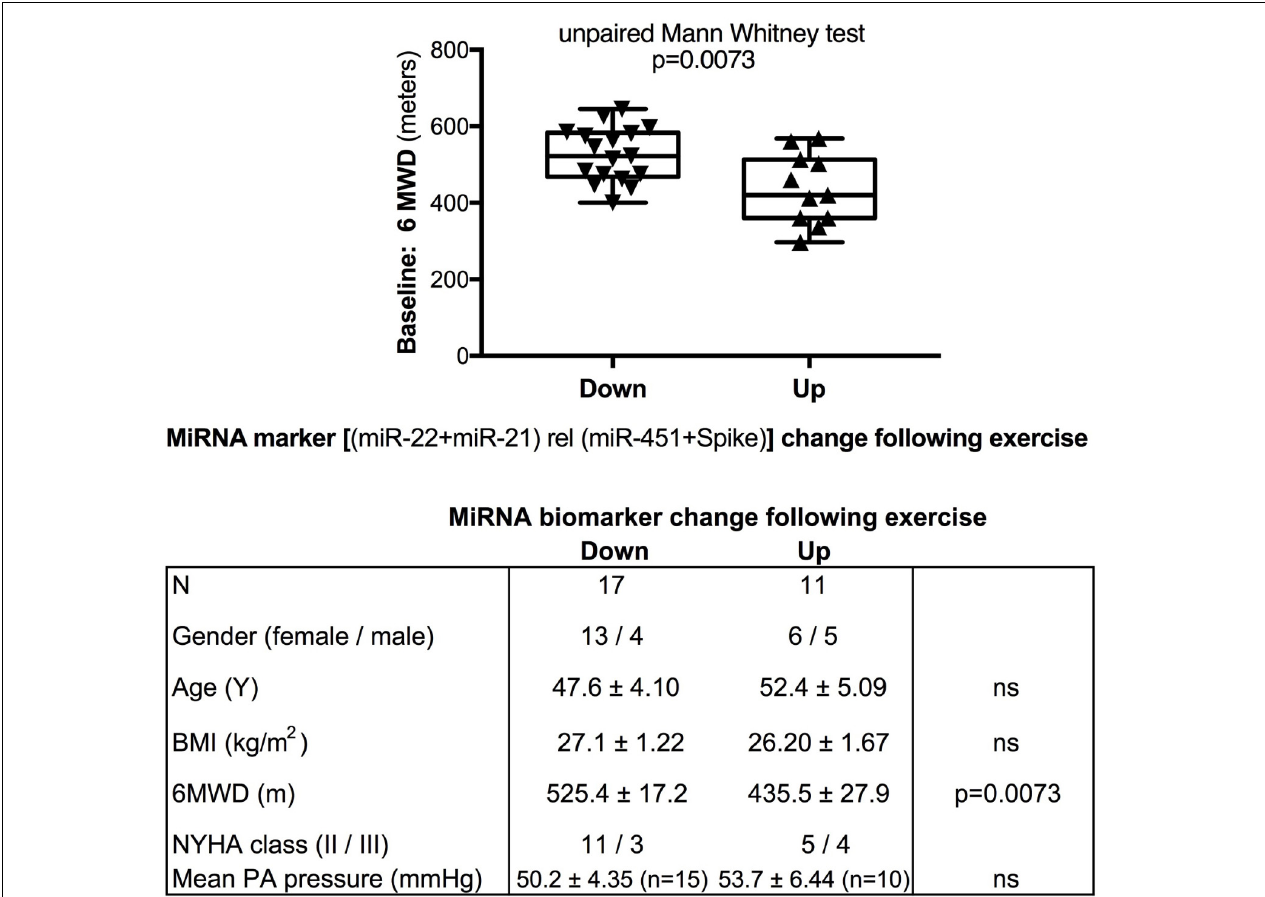
FIGURE 3 | Baseline 6-min walking distance in the exercise training intervention study - comparison with directional change of the miRNA marker. Box-plots with whiskers and individual points show 6-min-walking-distance (6MWD, m) measured at baseline examination from patients in the exercise training intervention study. The data were grouped by the directional change of the miR-22-3p + miR-21-5p relative to spike-RNA + miR-451a (10,000 × ) values after versus before exercise training intervention: down or up, as shown in Figure 2D . Groups were compared with the unpaired, 2-tailed Mann–Whitney test; p < 0.05 was considered significant, ns is not significant. The table graph lists the characteristics of the sample donors for each group. For this analysis, samples from three patients who had a body mass index (BMI) greater that 40 kg/m 2 and who achieved 6-min-walking-distances between 150 and 190 m were omitted; two of these three patients were NYHA class III, one was NYHA class not